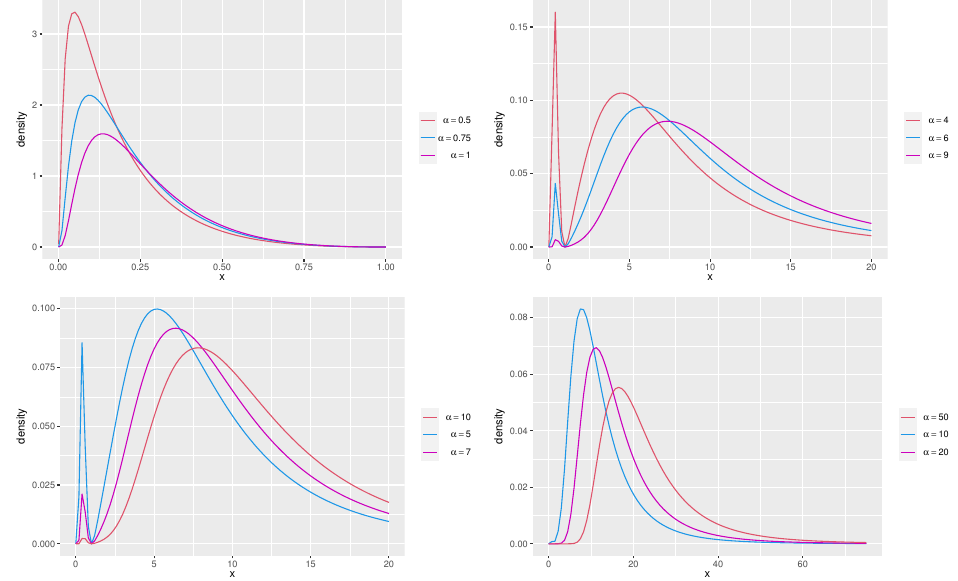
Figure 1. Probability density function of the EBLN distribution for some selected values of α